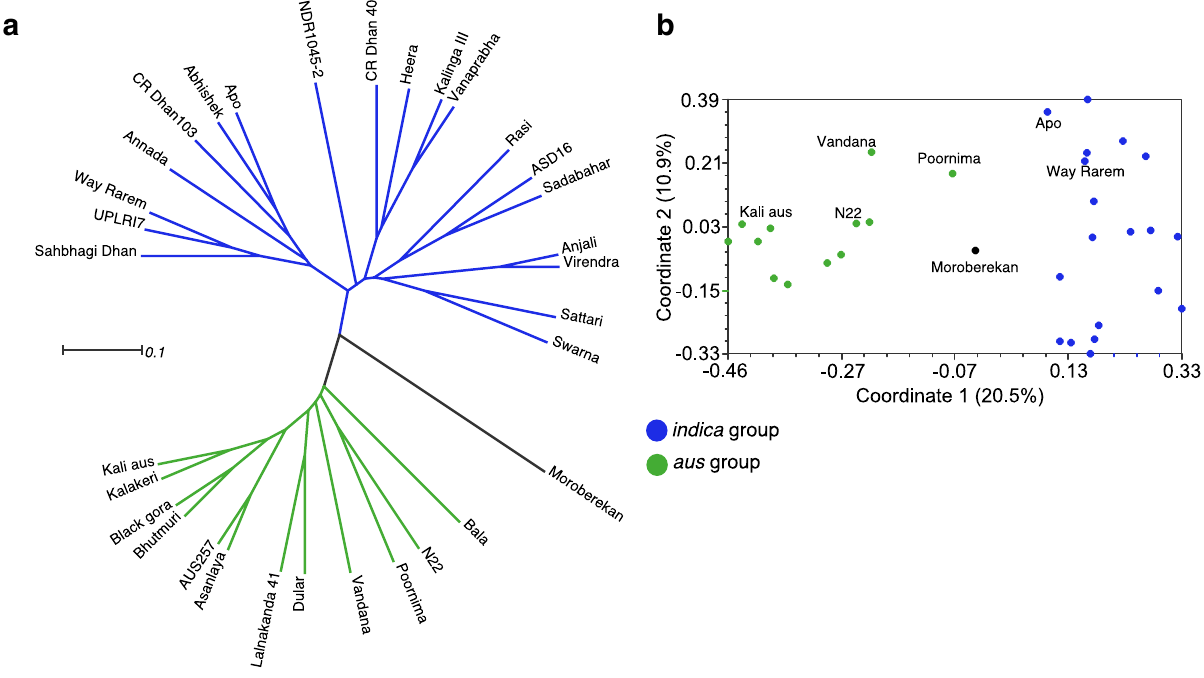
Figure 1. The genetic relationships between 32 rice genotypes based on 24 DTY QTL-linked SSR markers. ( a ) A UPGMA phylogenetic tree showing the clustering of rice cultivars into indica and aus groups. ( b ) Principal coordinate analysis with the indica and aus groups colour coded. The figure was edited for presentation using Affinity Designer 1.9.3 (https:// affin ity. serif. com/ en-